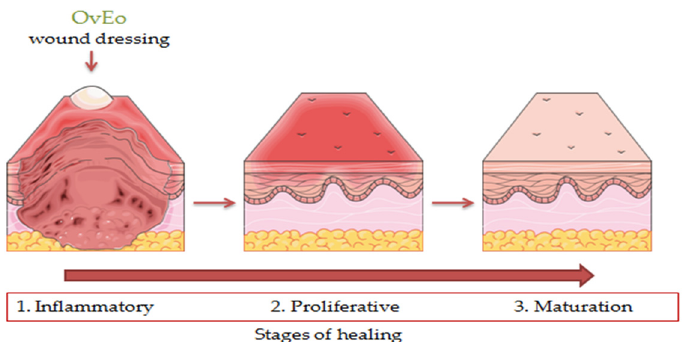
Figure 8. A snapshot of the wound healing effect of OvEo. A snapshot of the cutaneous effects of Origanum vulgare L. essential oil is presented in Figure 9.